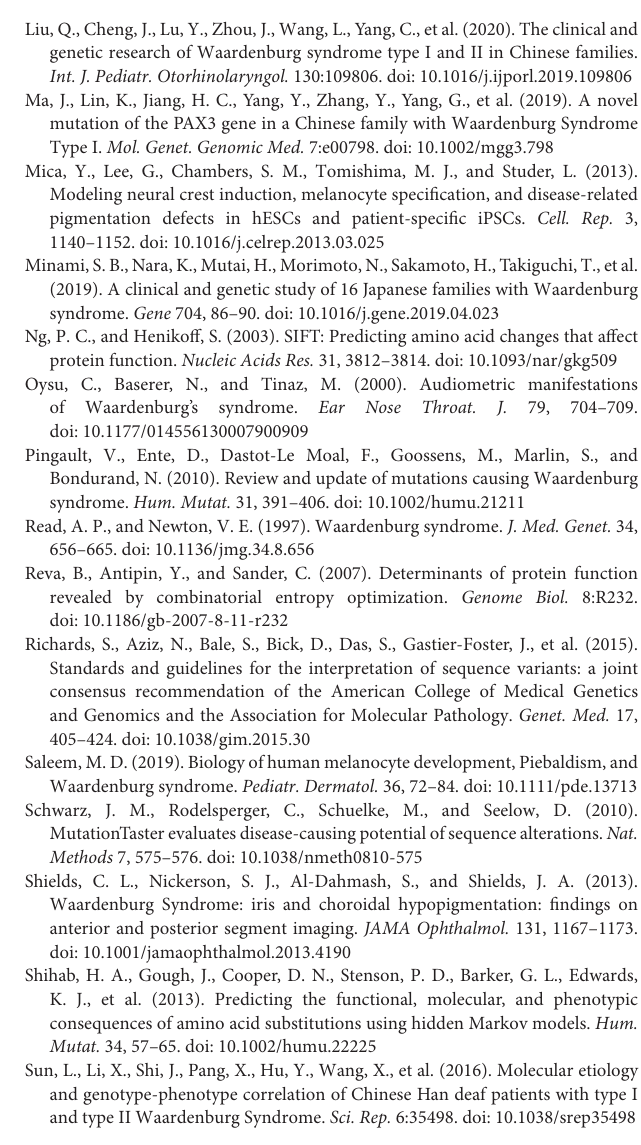
Supplementary Figure 1 | The c.959-5T > G mutation in the PAX3 gene, which is identified in III-1 (proband), II-1, II-8, II-10 and III-2. The wild type is identified in